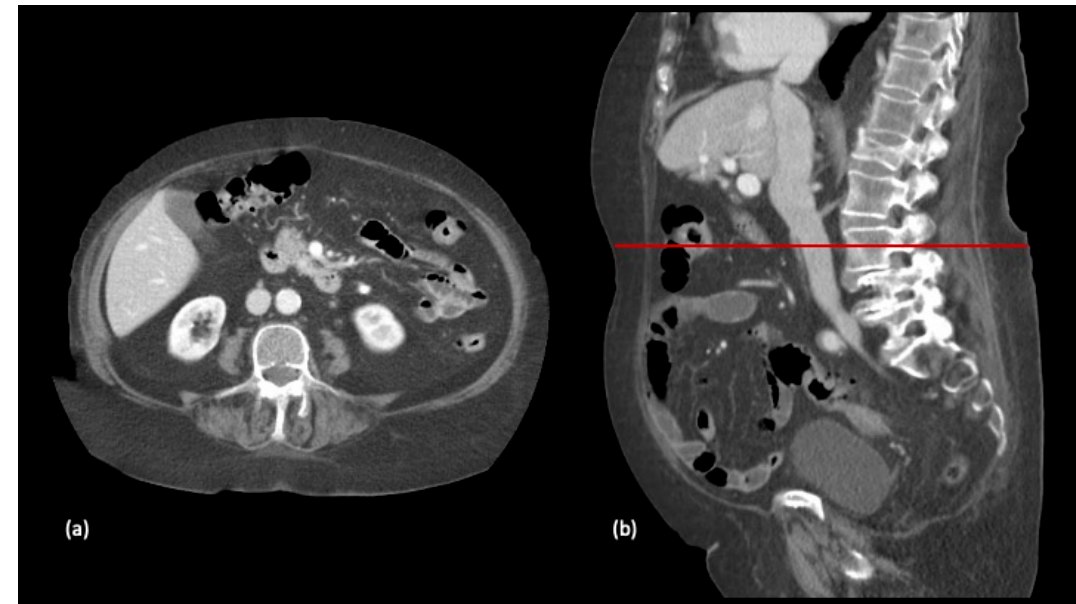
Figure 1. Selection of axial ( a ) and sagittal ( b ) slices at the level of the third lumbar vertebra in a preparatory computed tomography study.